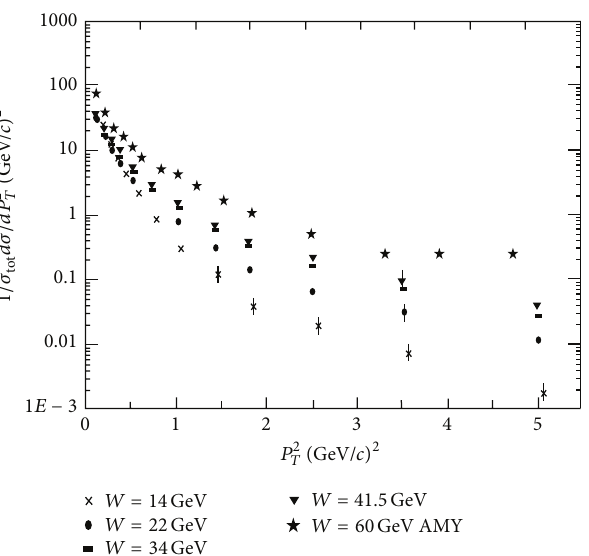
⟩ , at 𝑇 out Figure 8: Normalized differential cross section as a function of the squared transverse momentum of the charged particles, )(𝑑𝜎/𝑑𝑃 2 )) , for different center of mass energies ((1/𝜎 tot 𝑇